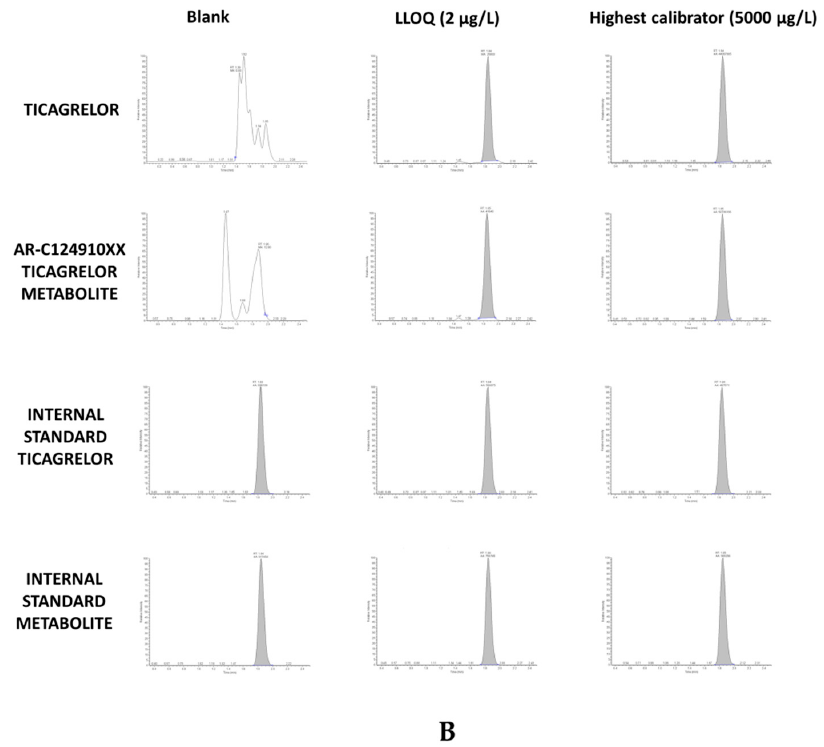
Figure 1. ( A ) Chemical structures of ticagrelor and its active metabolite AR-C124910XX. ( B ) Typical chromatograms of the analytes in blank human plasma samples, at 2 µg/L, the lower limit of quantification (LLOQ), at 5000 µg/L the highest concentration from calibration curves. For each analyte, the chromatograms were obtained from the highest intensity used for quantification.